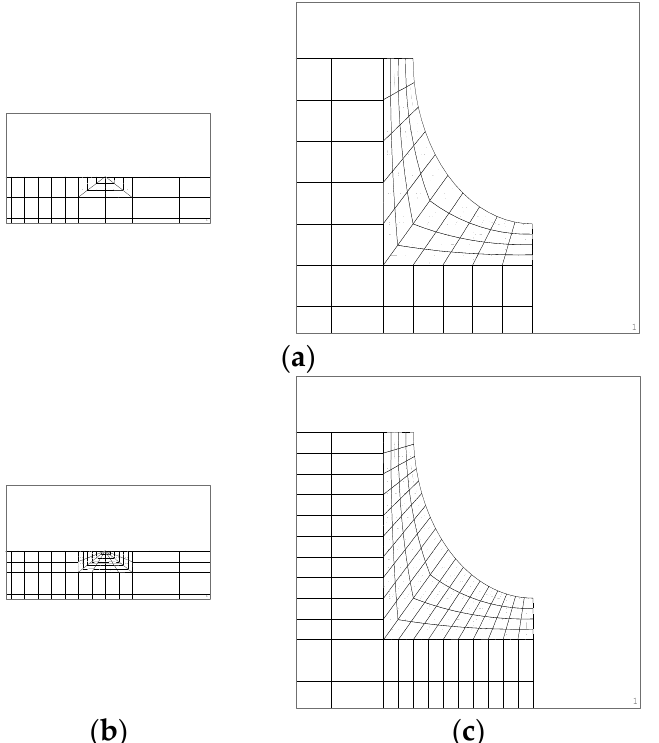
Figure 4. Mesh details: ( a ) crack tip and notch area of the mesh A; ( b ) mesh B, more refined at the crack tip; ( c ) mesh C, more refined around the notch. Table 2. Number of mesh elements.